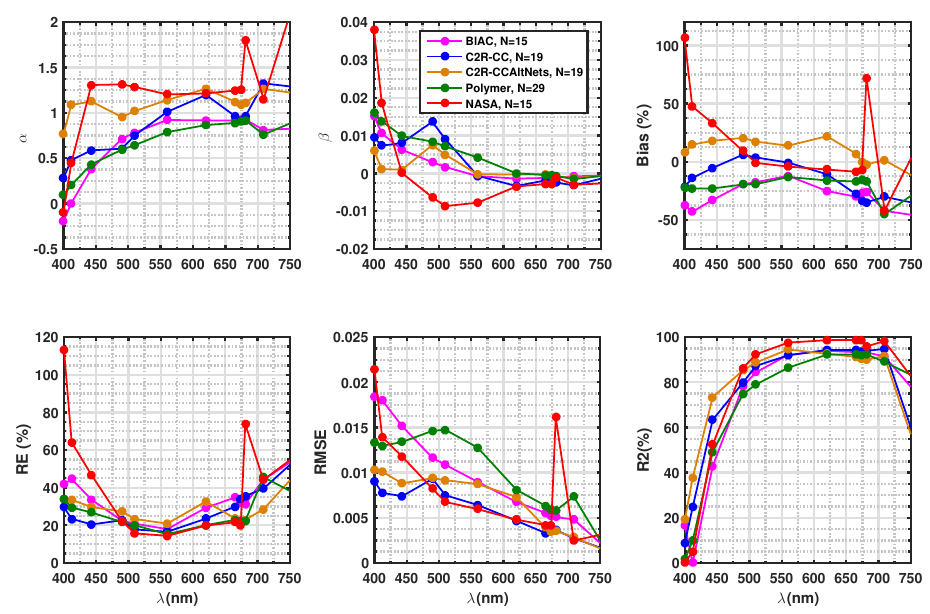
Figure 7. Statistical properties without negative values between 400 and 754 of the AC match-ups evolution as a function of wavelength between 400 and 750 nm. The statistical properties: slope ( α ), intercept ( β ), bias, relative error (RE), root mean squared error (RMSE), and correlation coefficient ( R 2 ) are represented in the y-axes in the subplots starting from the left-top subplot until the right-bottom subplot, respectively. The x-axis represents the variation of the wavelength between 400 and 750 nm. The color code is similar to that in Figure 3 and given in the top middle subplot with the match-ups numbers.